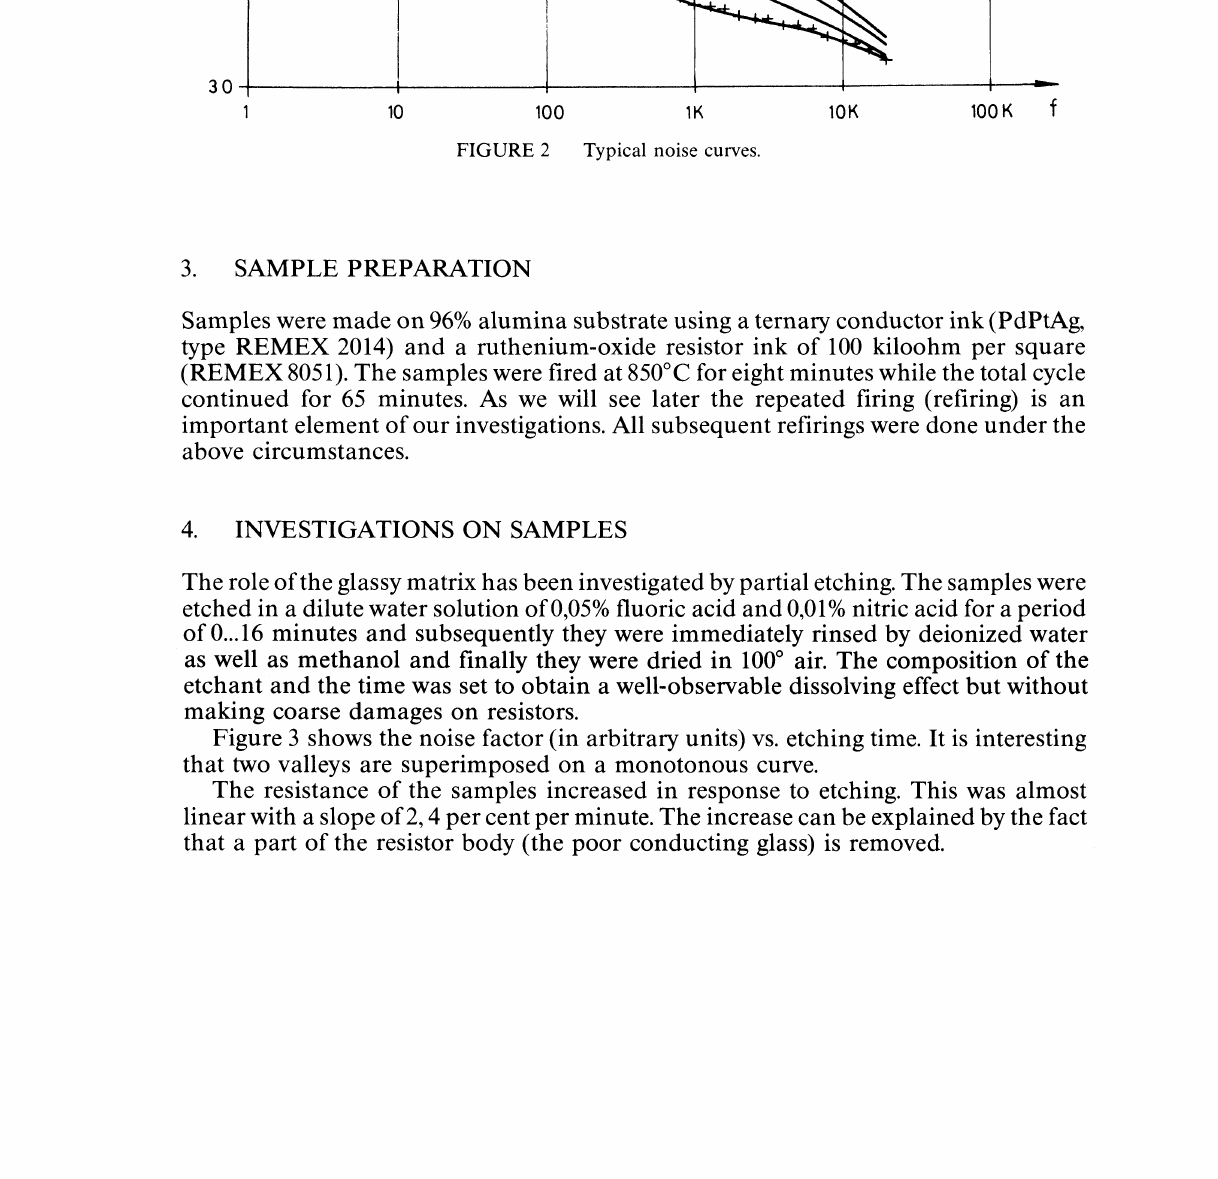
FIGURE 2 Typical noise